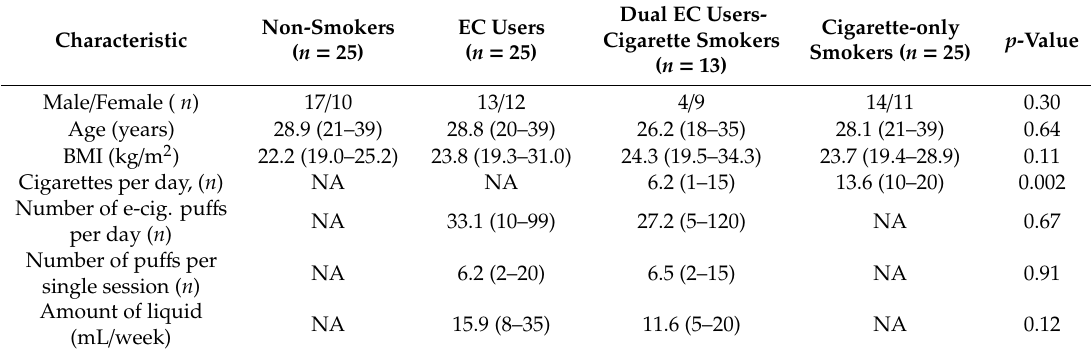
Table 1. Participant characteristics.